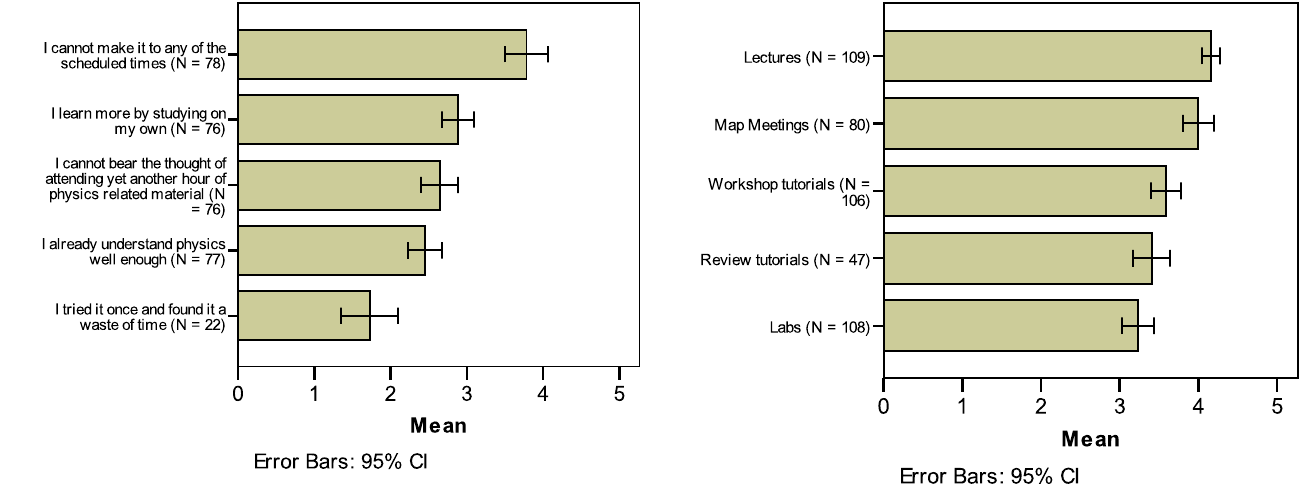
FIG. 8. (cid:1) Color online (cid:2) Student response to “The following were useful for learning physics (cid:1) only rate those you went to (cid:2)